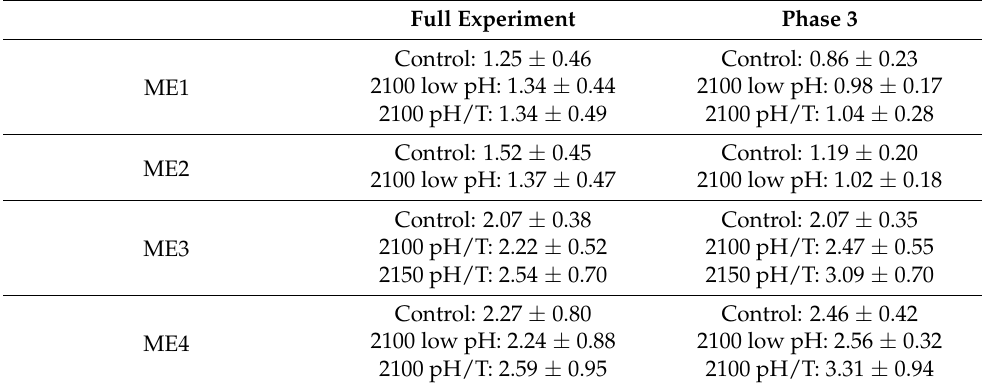
Table 2. Average Chl- a concentration in µ g L − 1 in the four mesocosms experiments over the full experiment duration and in Phase 3 with the associated standard deviation.